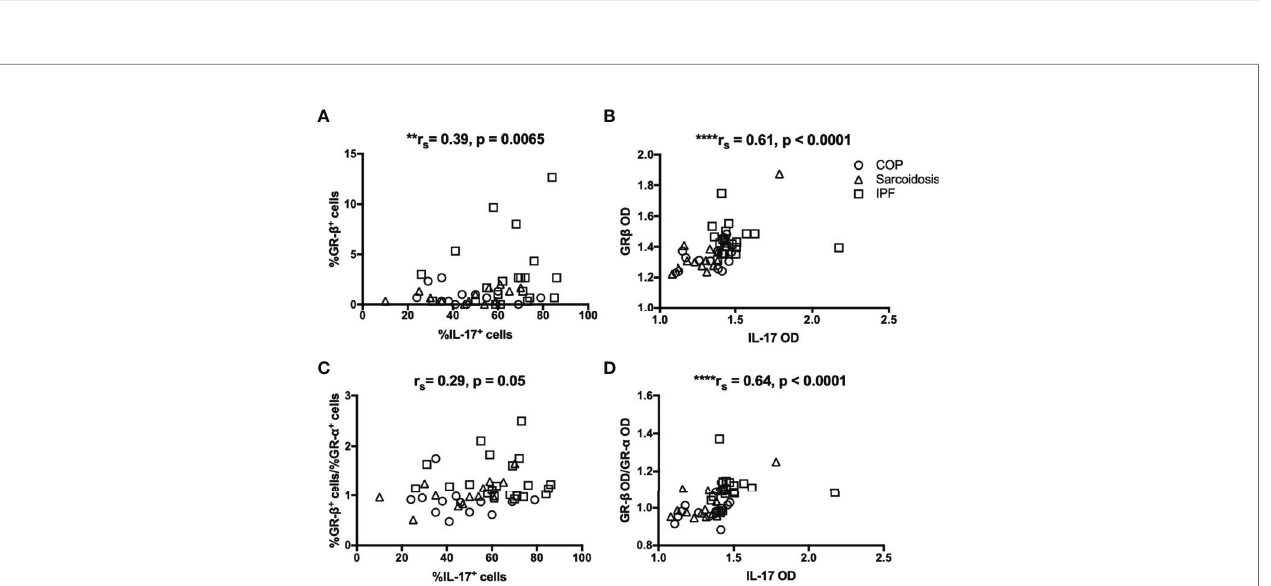
FIGURE 4 | The relationship between IL-17 and GR isoforms in ILDs. (A – D) Immunohistochemical staining showed IL-17 expression was positively associated with GR- b and GR- b /GR- a ratio in ILD lungs (COP, sarcoidosis and IPF in combination). IL-17, interleukin; ILD, interstitial lung disease; IPF, idiopathic pulmonary fi brosis; COP, cryptogenic organizing pneumonia; GR, glucocorticoid receptor; HDAC2, histone deacetylase 2; OD, opacity density score. **p < 0.01, ****p <